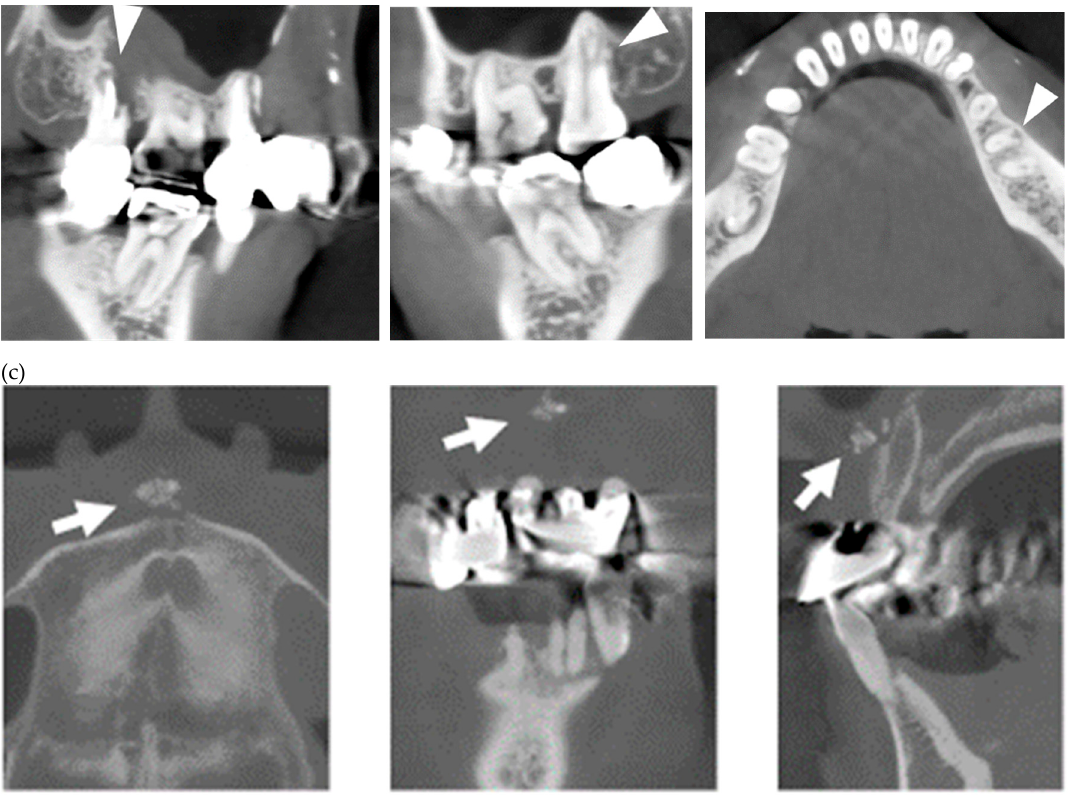
Figure 2. Multiple external root resorption and calcinosis at the oral region in pt. 3. A dental X-ray photo and CBCT image of teeth ( a , b ) and the deposition of calcinosis at the nasal spur ( c ). The white arrowhead points to root resorption, the black arrowhead to PDL space widening, the white arrow at calcinosis and the black arrow indicates the failure to close the space with orthodontic treatment.